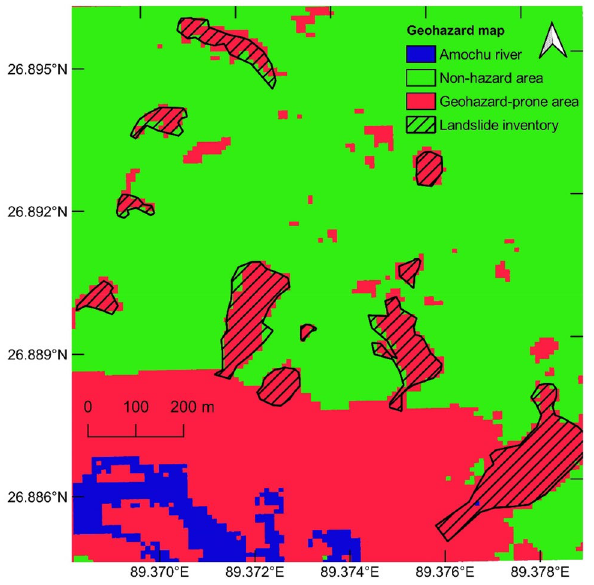
Fig. 8 Delineated geohazard map from land cover classification (FR